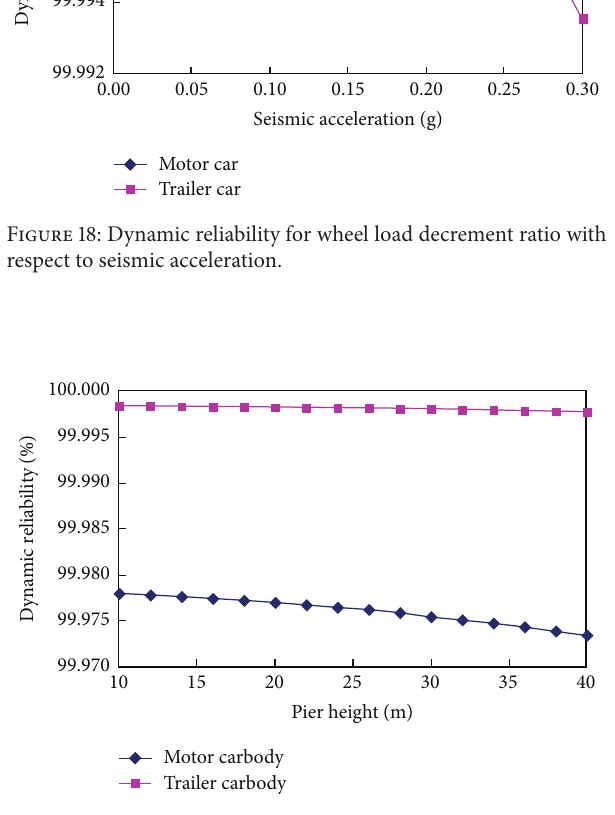
Figure 16: Dynamic reliability for carbody lateral acceleration with respect to seismic acceleration.